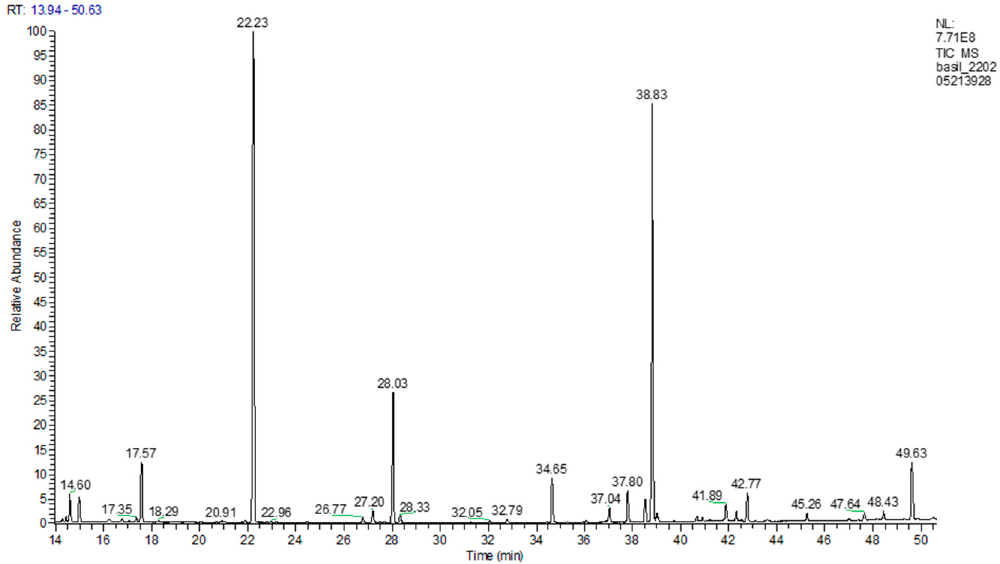
Figure 1. Chromatogram of the components identified in BEO. Table 2. Main components of BEO.